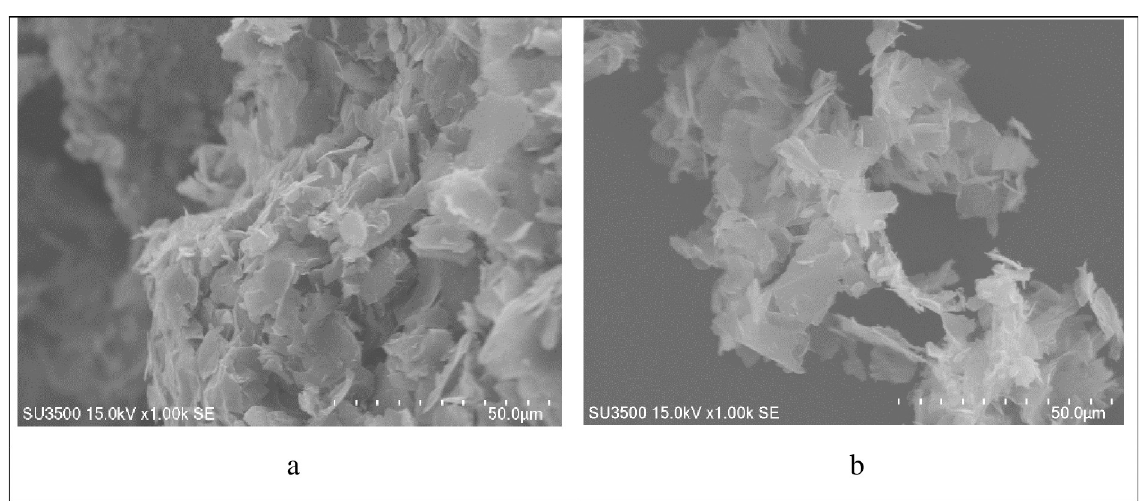
Fig 3. SEM image of the (a) bio graphene obtained from corn stover using thermo-chemical process and (b) functionalized bio grapheme using grafting amine group’s method.